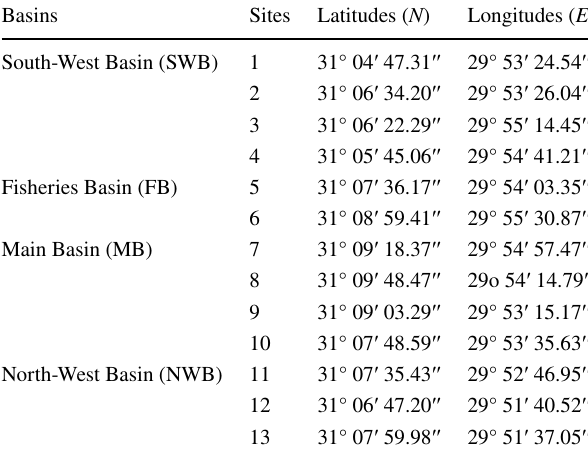
Table 1 Details, latitudes, and longitudes of the sampling locations in Mariout Lake